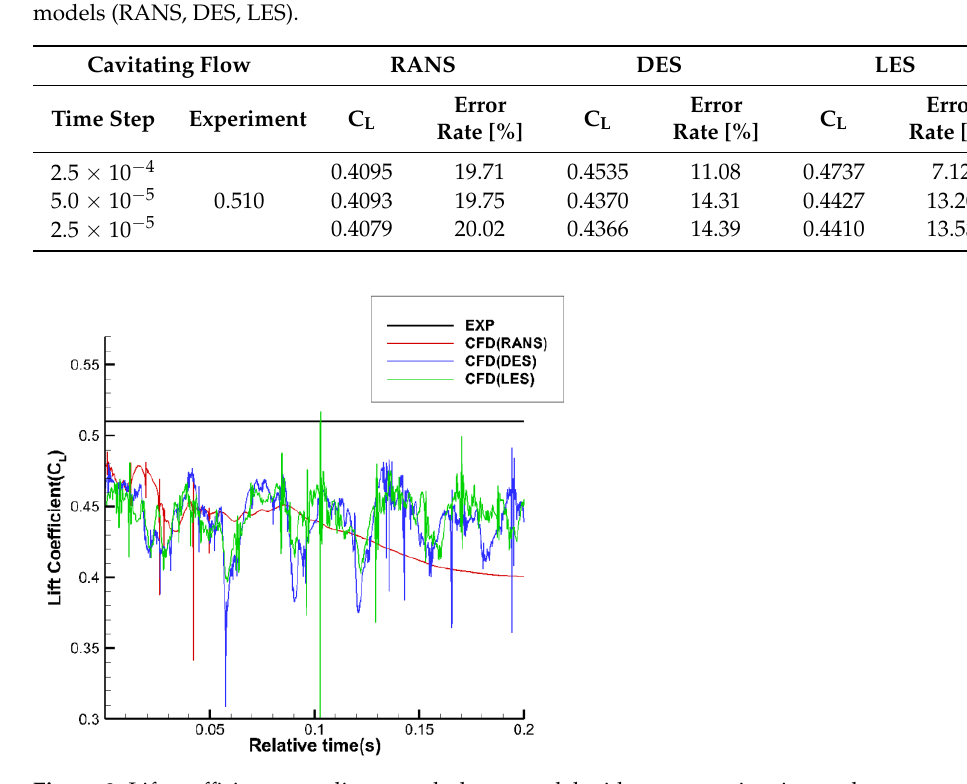
Figure 3. Lift coefficient according to turbulence model with a narrow time interval.